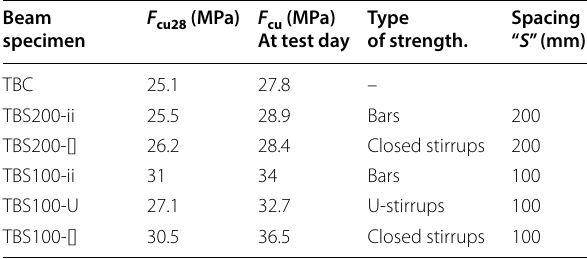
Table 5 Properties of the concrete and specimen details. Beam